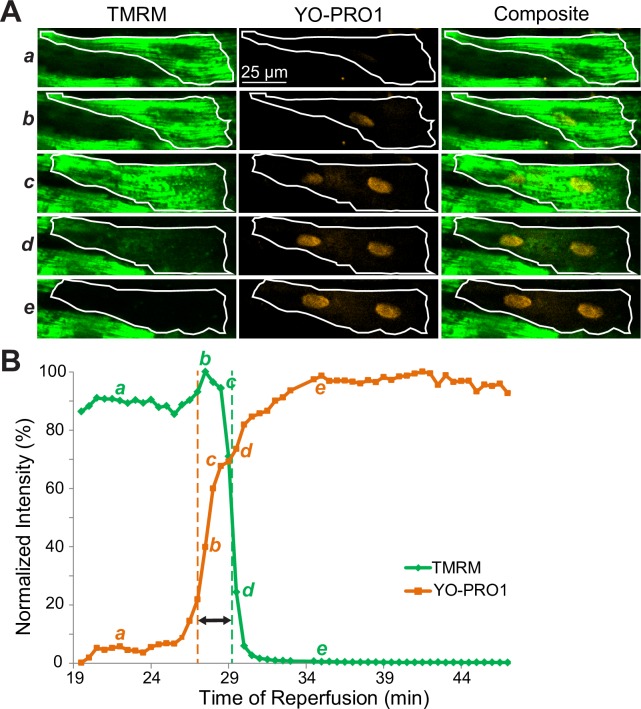
Detailed spatiotemporal analysis of FTMRM loss and FYO-PRO1 gain during reperfusion in a myocyte from a heart treated with CsA (0.2 μM).Notations are the same as in Fig 1. Note that compared to a myocyte from a control heart shown in Fig 1, the earliest detectable FYO-PRO1 gain (indicator of SP), which is observed at the time point b, clearly occurs before the processes of FTMRM loss (indicator of MPT).